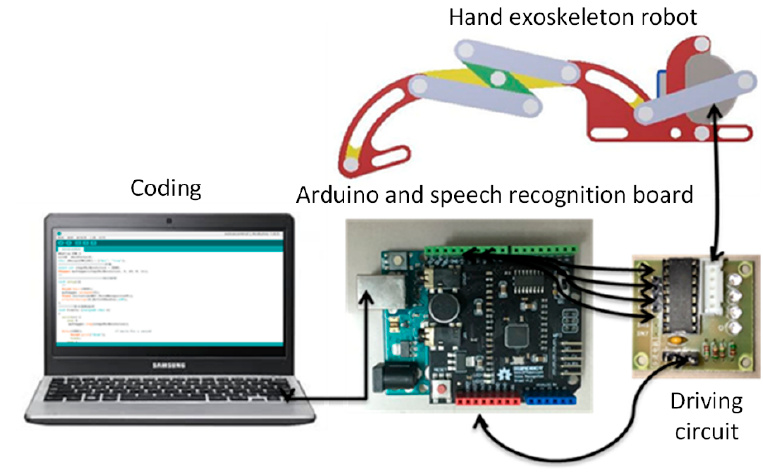
Figure 3. Experimental setup.